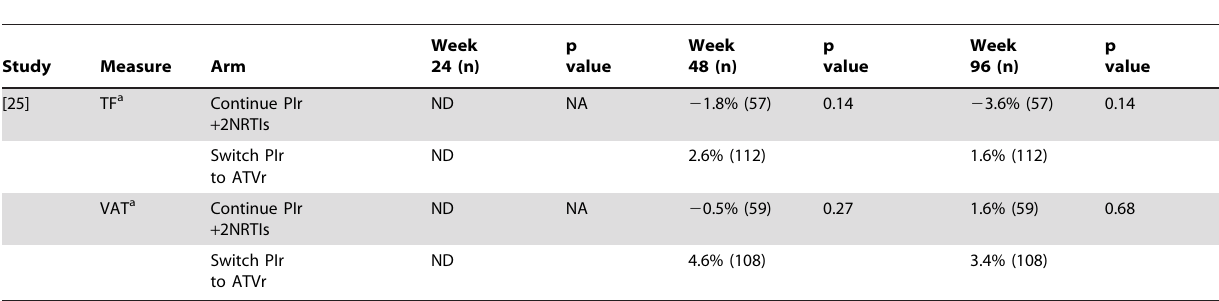
Table 25. Switching studies: change from baseline in trunk fat (TF) on DEXA scan and visceral adipose tissue (VAT) on CT scan: PI versus